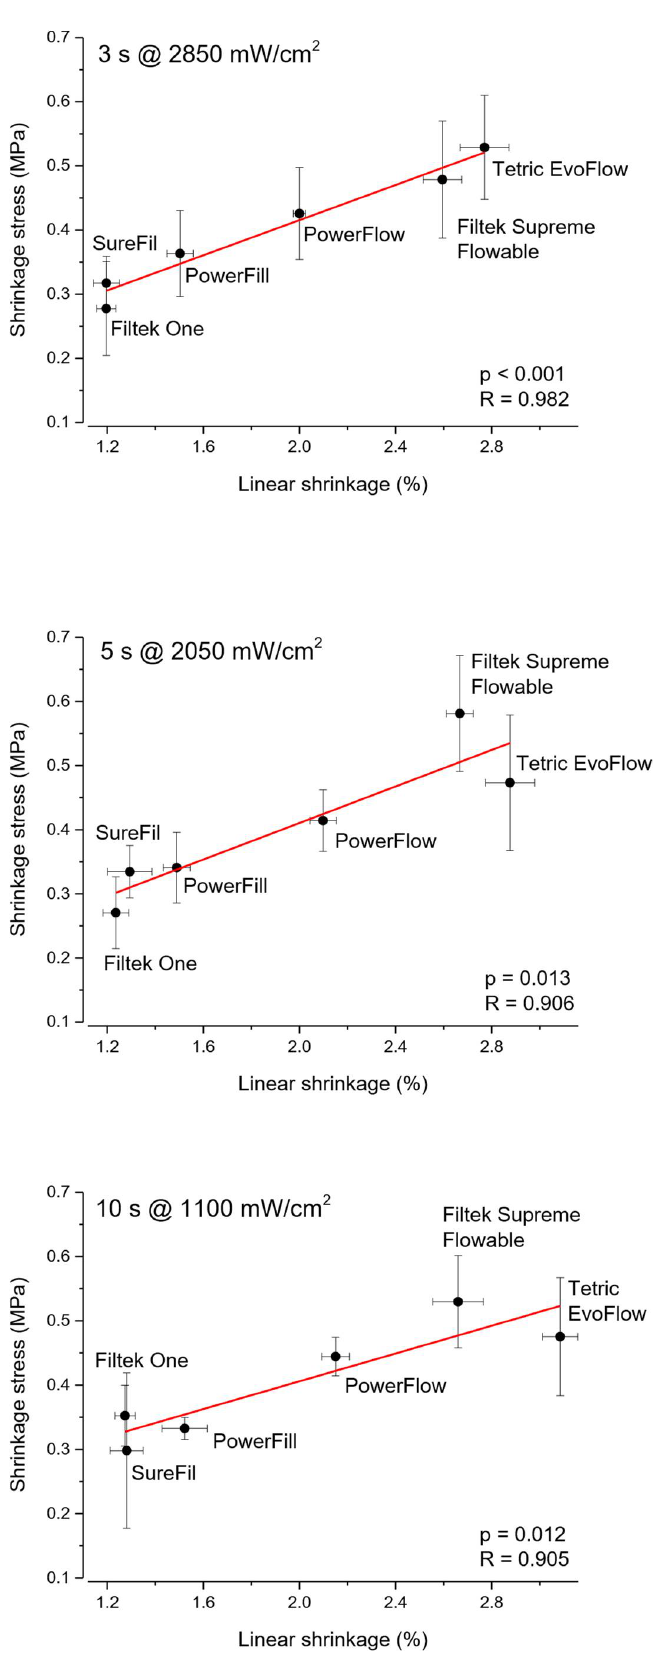
Figure 5. Scatterplots of shrinkage stress as a function of linear shrinkage and results of Pearson correlation analysis. Error bars represent ± 1 standard deviation.